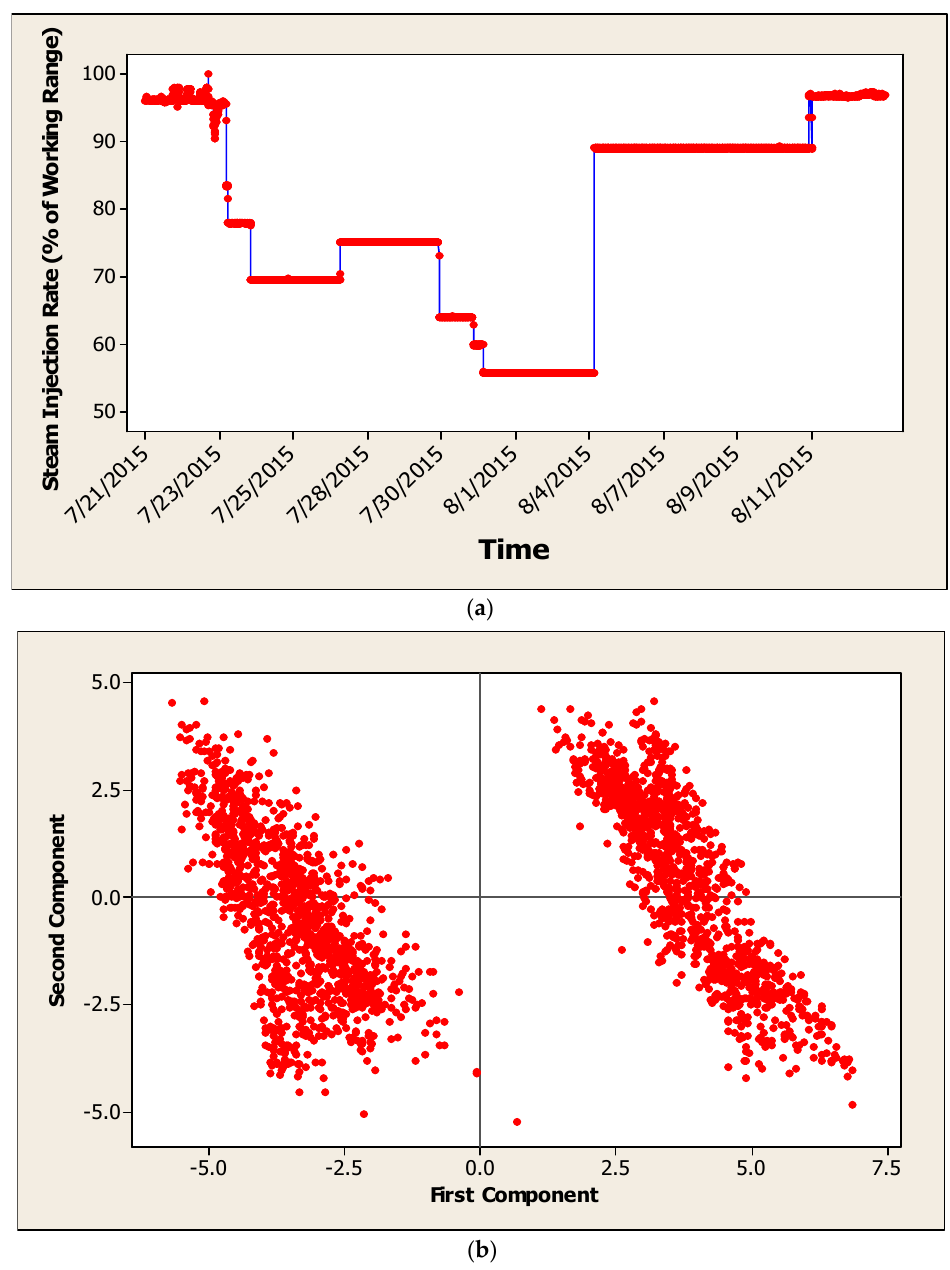
Figure 3. Data and preliminary results from the performance test: ( a ) steam injection rate used during the performance test, and ( b ) principal component analysis (PCA) of data collected from the performance test.